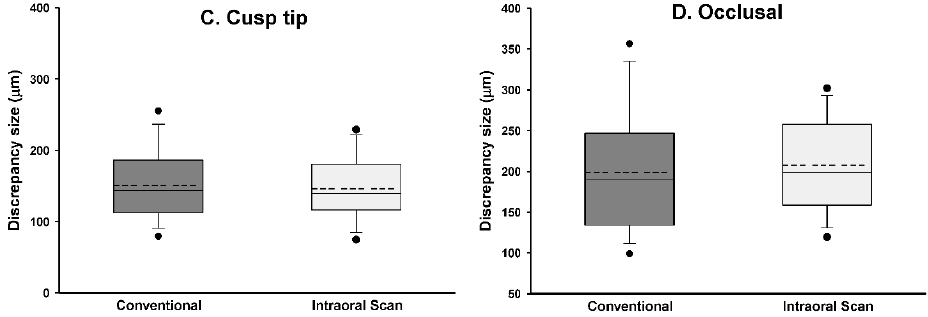
Figure 9. Box plots of discrepancies in the four regions of interest, ( A ) marginal discrepancy, ( B ) axial discrepancy, ( C ) discrepancy in the cusp tip, and ( D ) occlusal discrepancy.